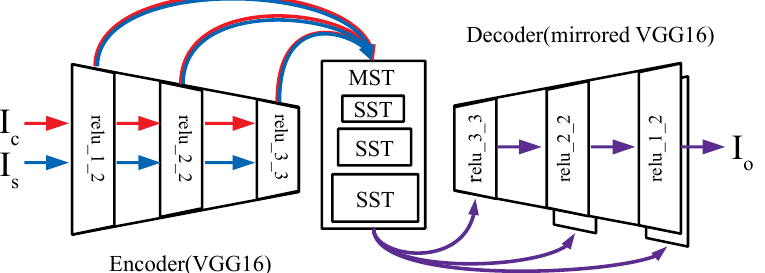
Figure 2. Network structure diagram for applying multi-scaled stylization: Our Multi-Scaled style Transformer (MST) transfers multi-scaled styles in a feed-forwarding process by using internal Single-Scale feature Transforms (SSTs) and a skip-connected